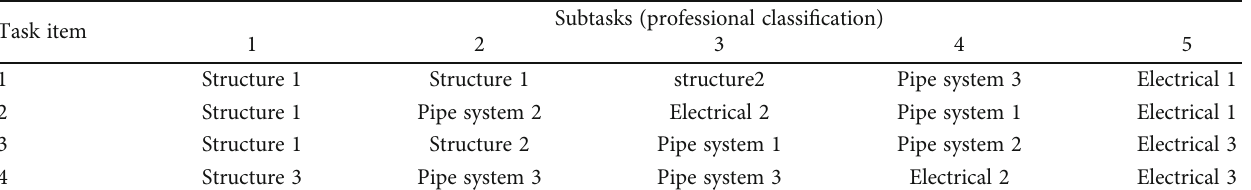
Table 7: Design task.